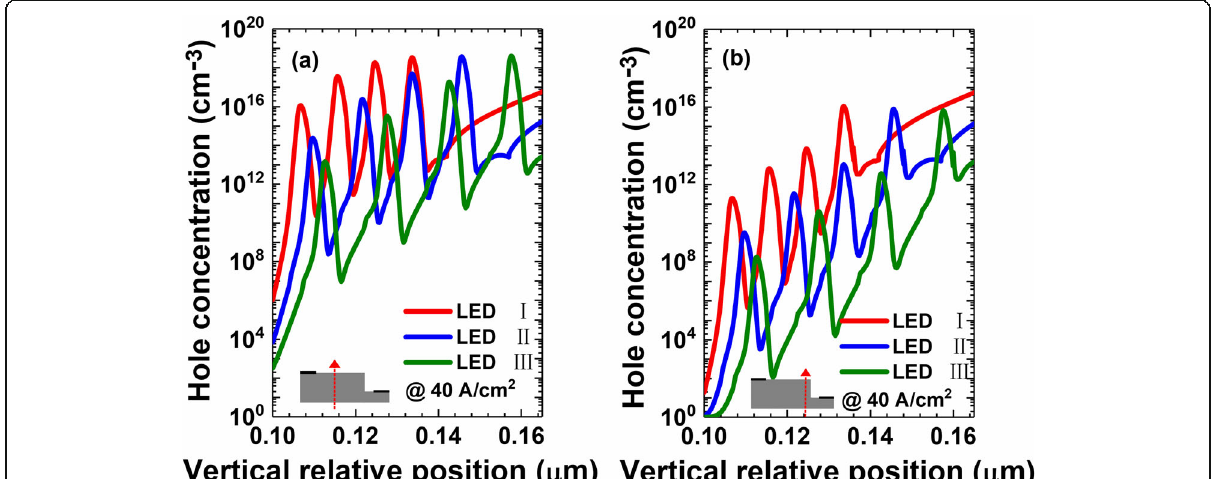
Fig. 7 Numerically calculated hole concentration profiles in the MQW region ( a ) in the center, ( b ) at the edge of the mesas for μ LEDs I, II, and III, respectively. Data are calculated at the current density of 40 A/cm 2 . Inset figures show the position along which the hole concentration profiles are captured